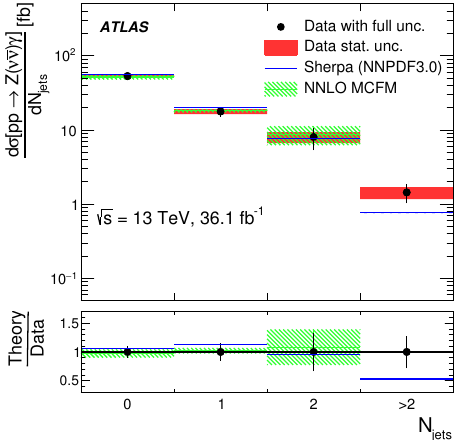
Figure 6 . The measured (points with error bars) and predicted cross sections as a function of N jets for the pp Z ( (cid:23) (cid:22) (cid:23) ) (cid:13) process in the extended (cid:12)ducial region. The error bars on the data points show ! the sum in quadrature of the statistical and systematic uncertainties. The Mcfm NNLO predictions are shown with shaded bands that indicate the theoretical uncertainties described in section 5.4. For the Sherpa predictions, systematic uncertainty is not considered, and the statistical uncertainties arising from the size of the MC samples are too small to be visible. The lower plots show the ratios of the SM expectation to the measured values (shaded bands), with the error bars on the points showing the relative uncertainties in the experimental measurements.